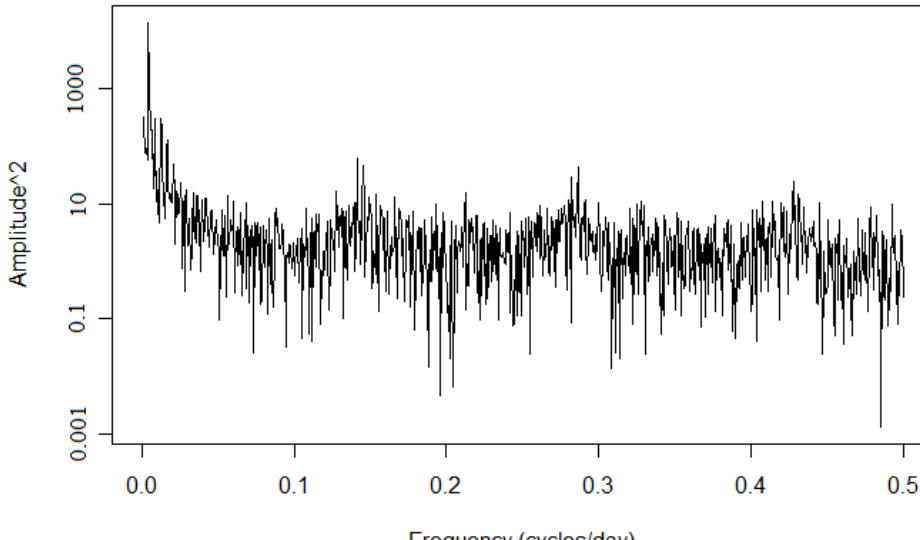
Figure 5. Power spectrum log–log for